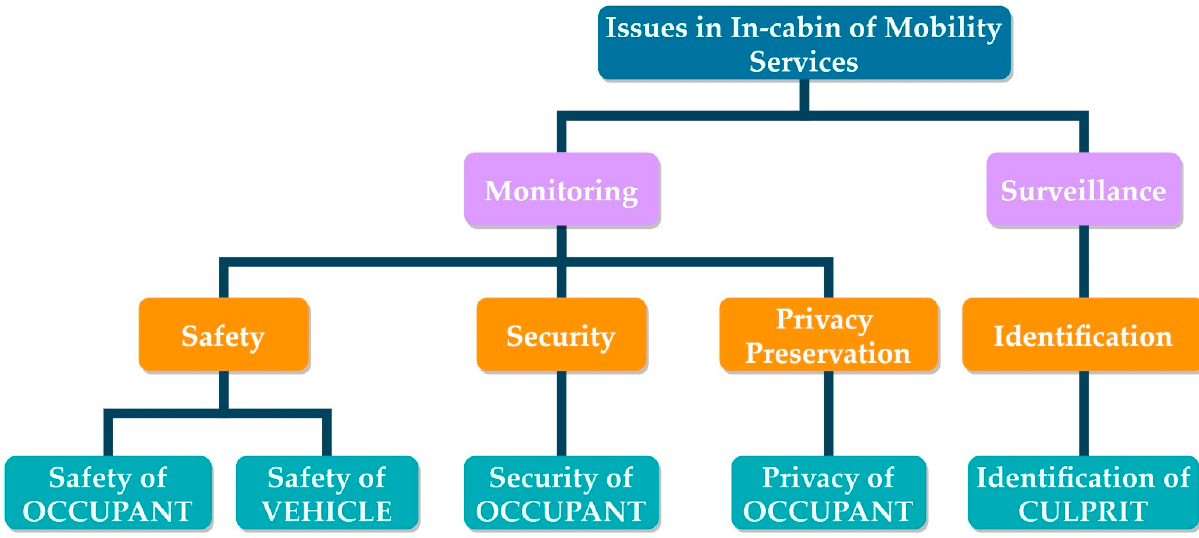
Figure 2. Monitoring and surveillance are essential in highly automated driving. Broader categoriza- tions are related to the safety, security, and privacy of the